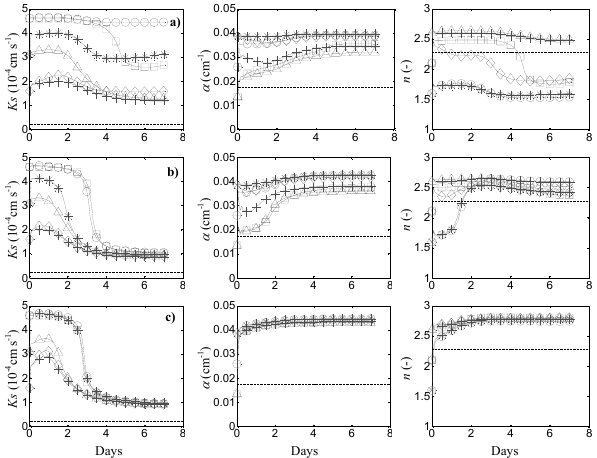
Figure 2. Retrieved VGM parameters K s , α and n for GA3 soil sample with assimilation frequency AF = 1/2h − 1 , and observation depth (a) OD = 1cm, (b) OD = 2cm and (c) OD = 12cm. Compar- isons account for the six pondered sets of initial parameters S1( (cid:13) ), S2( (cid:3) ), S3( ∗ ) , S4( 1) , S5( + ) and S6( ♦ ) . The dotted line indicates the value of the parameter found by Romano and Santini